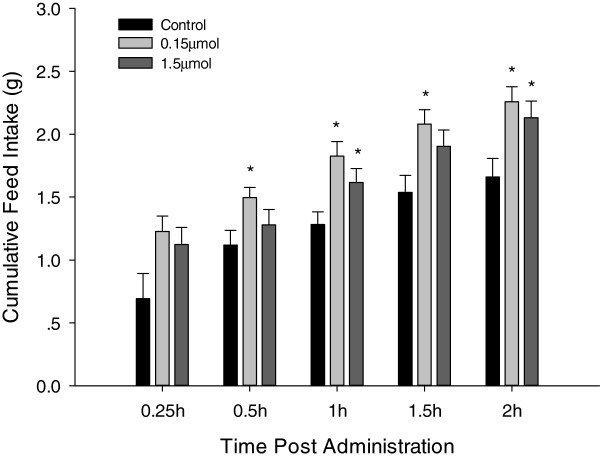
Cumulative feed intake of broiler chicks after ICV administration with saline (control, n = 9), 0.15 μmol (n = 9) or 1.5 μmol (n = 9) L-leucine. Feed intake was recorded at 0.25, 0.5, 1, 1.5, and 2 h post-administration; Data are represented as means ± S.E.M. Asterisk indicates significant difference from control group within each time point (P < 0.05).